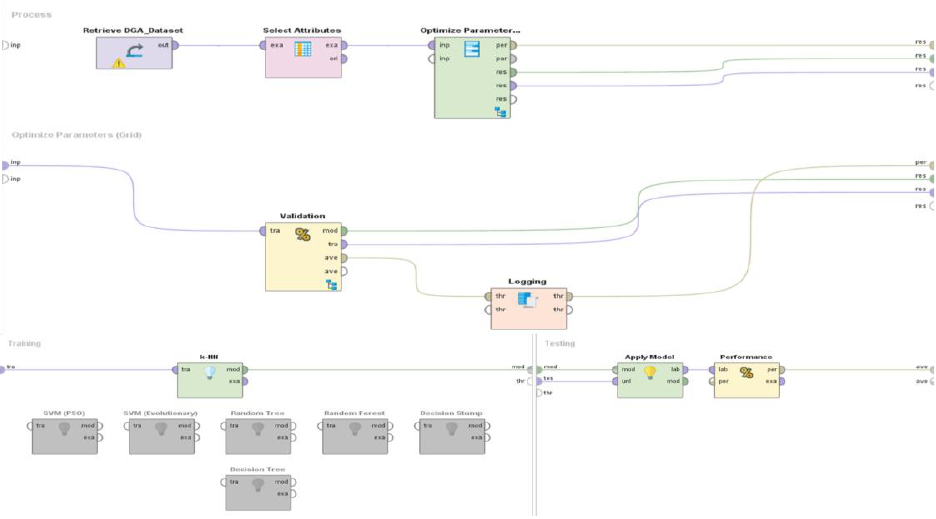
Figure 7. Classification comparative on